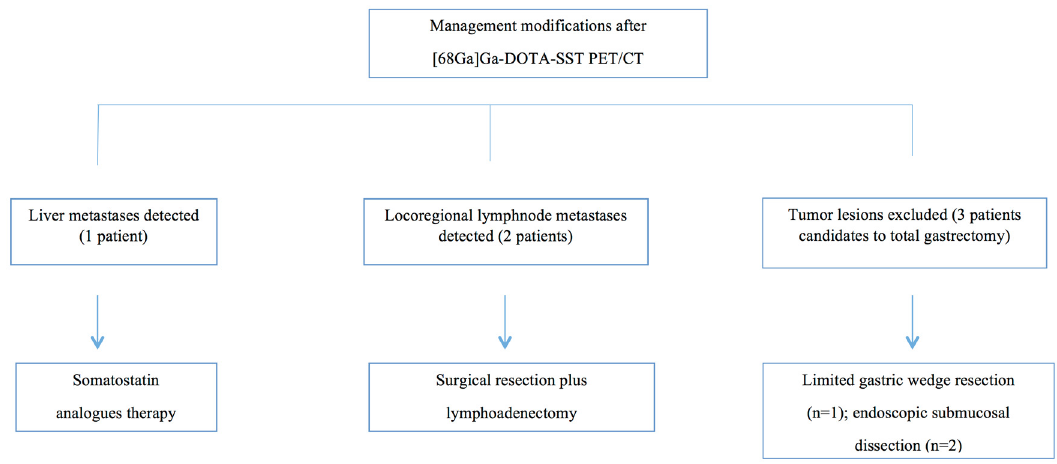
Figure 3. Clinical management changes.